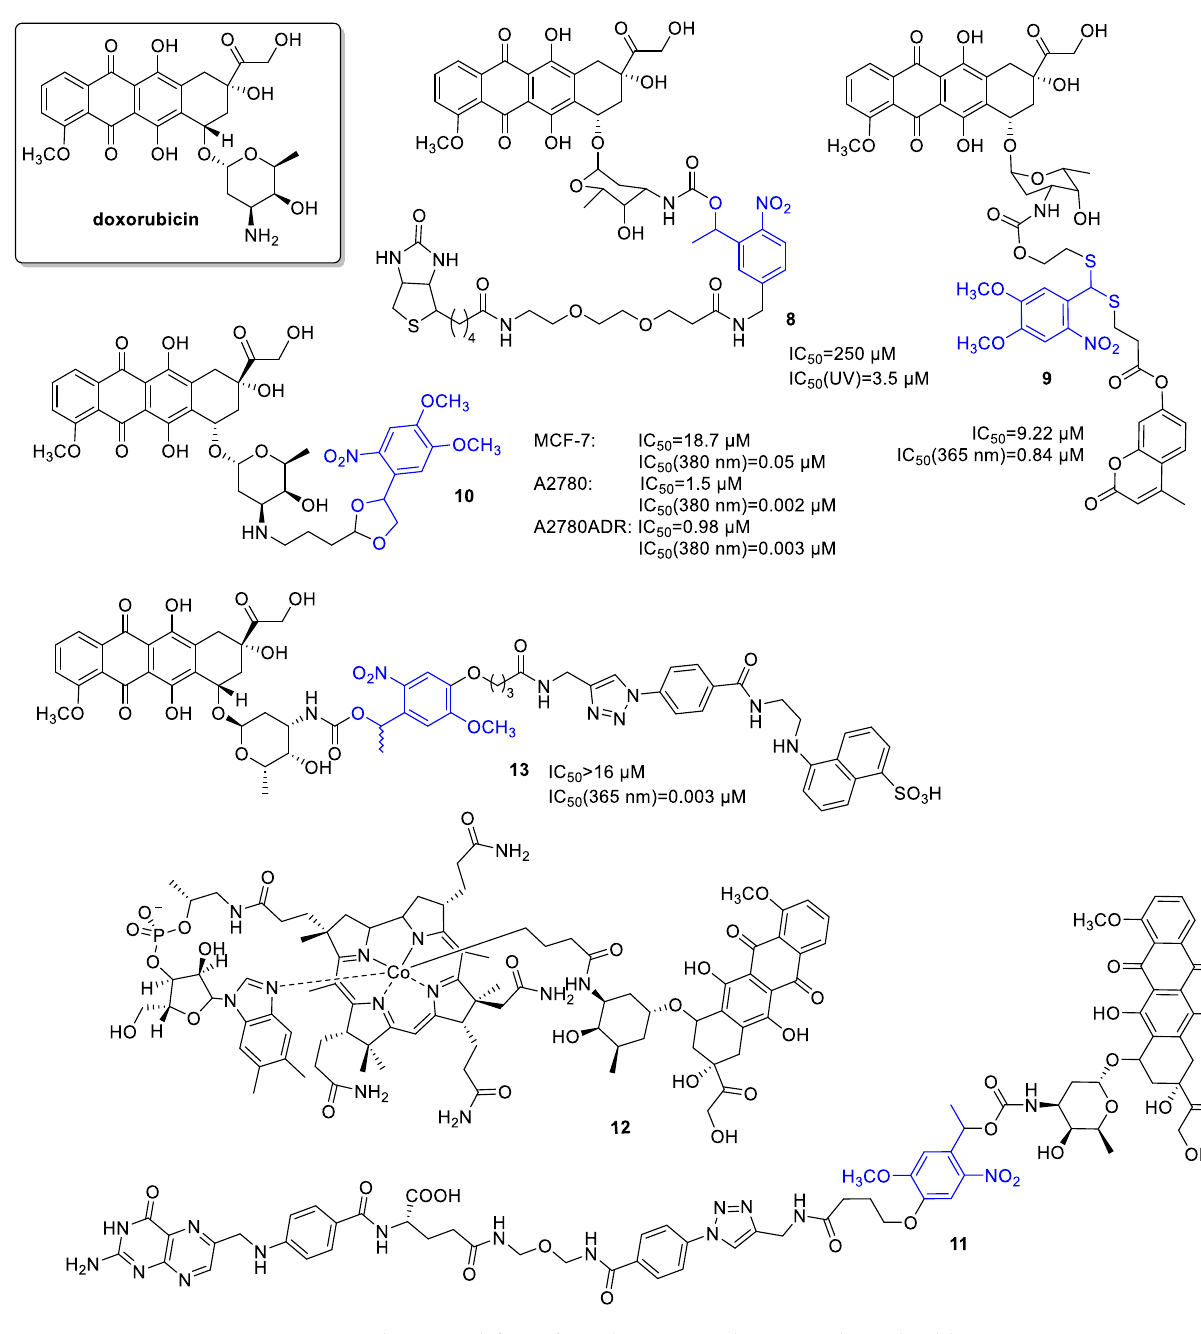
Figure 4. Photocaged doxorubicin derivatives, the PPG indicated in blue. For therapeutic applications, using appropriate (longer) wavelengths has several Choi and coworkers studied the design and synthesis of a novel thioacetal ortho -nitrobenzaldehyde (TNB) dual-arm photocage [41] and its application for constructing practical consequences. One approach to harness long wavelengths, consequently low- energy photons, is to target sufficiently weak chemical bonds that could be directly dual drug-fluorescent reporter conjugates for controlled release and real-time fluorescent cleaved with lower energy. Lawrence and coworkers aimed to exploit the photohomolysis monitoring of drug activation in parallel. Optimally the two payloads are released simul- of the C-Co bond (<30 kcal/mol) in alkyl-cob(III)-alamins. The bond is weak enough to be taneously by cleaving the linker C-S bonds (resistant to many chemical conditions), and cleaved by any wavelengths between 330 and 560 nm absorbed by the corrin ring system several combinations of targeting ligands, drugs, etc., might be envisaged. For one [46]. To move further toward the optical window of tissues and to develop wavelength- tunable probes, constructs with additional fluorophores serving as light-capturing anten- nas were designed (TAMRA, SulfoCy5, Atto725, DyLight800, Alexa700, Bodipy650). The design rationale was that upon excitation beyond cobalamin absorption wavelengths, the